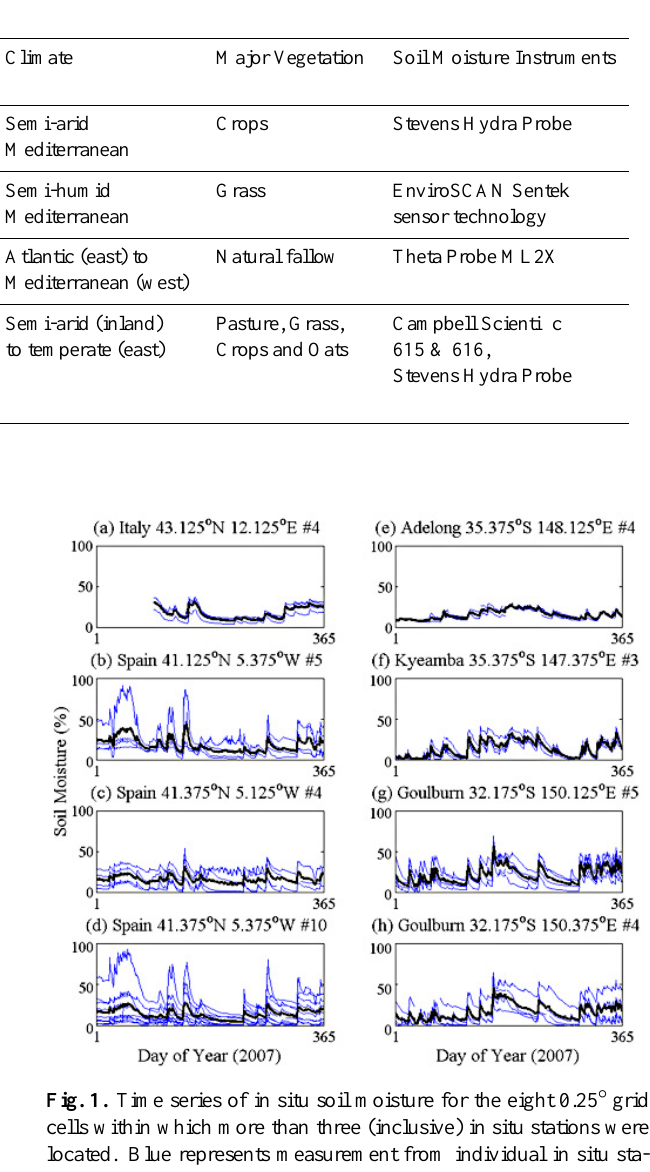
Table 1. Comparison of major characteristics of in situ soil moisture measurements used in this study. The OZNET network includes measurements within five catchments or basins. Numbers of in situ stations and grid cells covered are shown (more than one in situ station located within the same 0.25 ◦ grid cell in some networks).